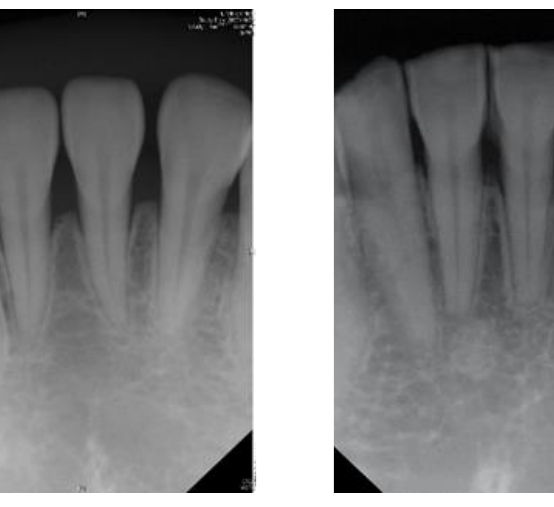
Figure 1. Periapical film